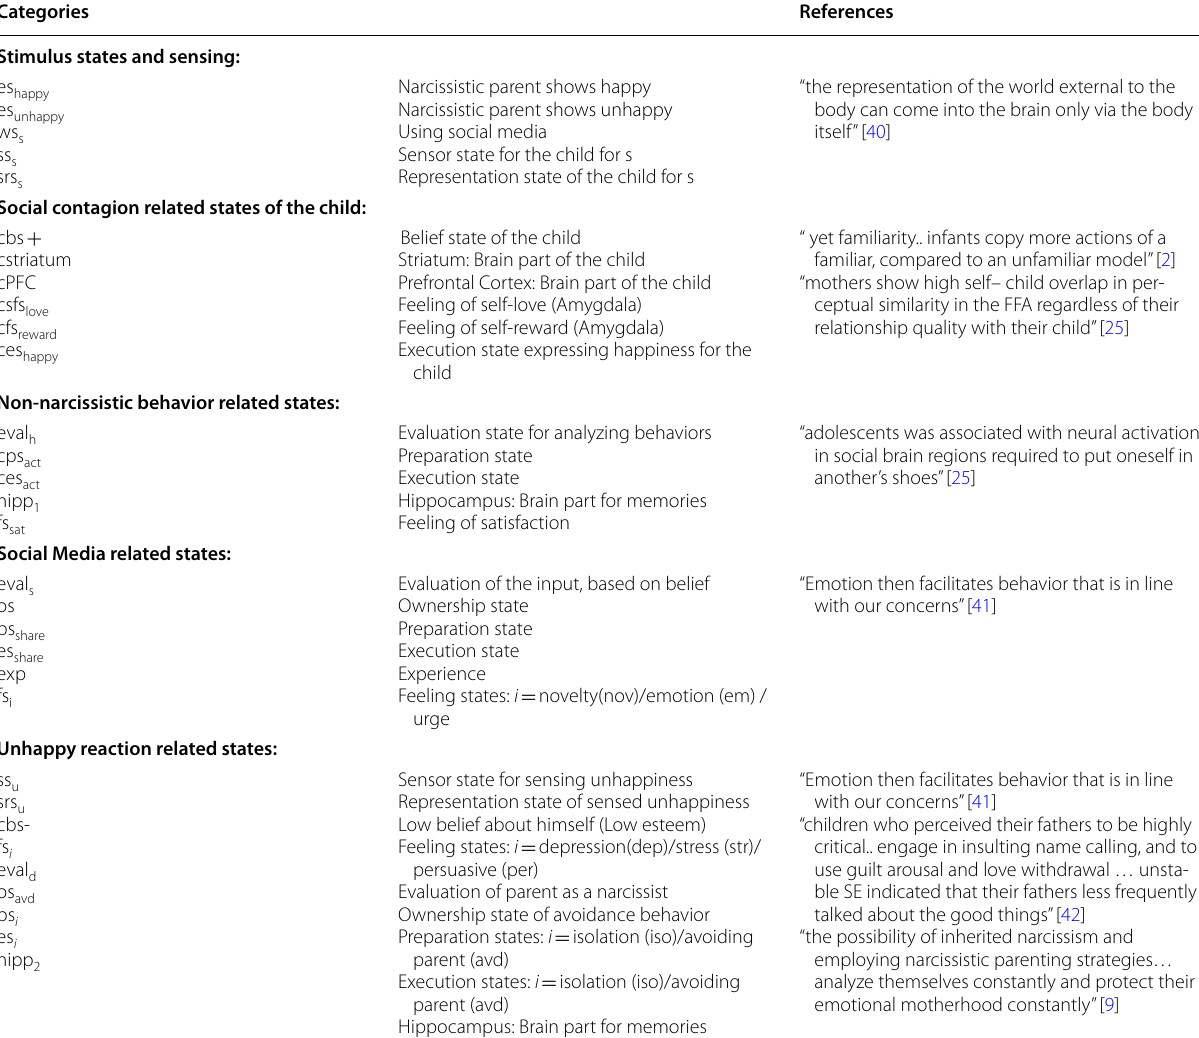
Table 1 Categorical explanation of states of the base model (Level